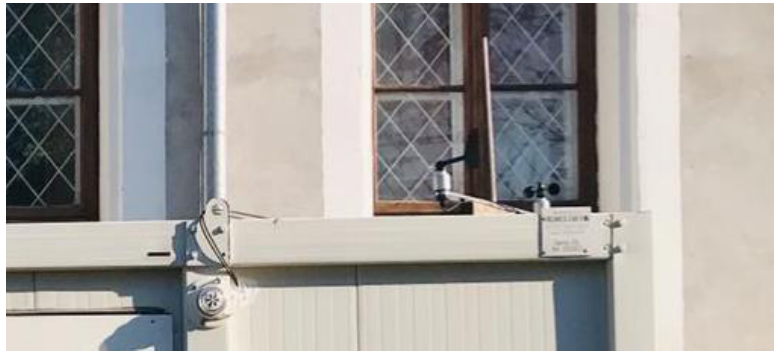
Figure 7. Installation of the weather station sensors on the container.